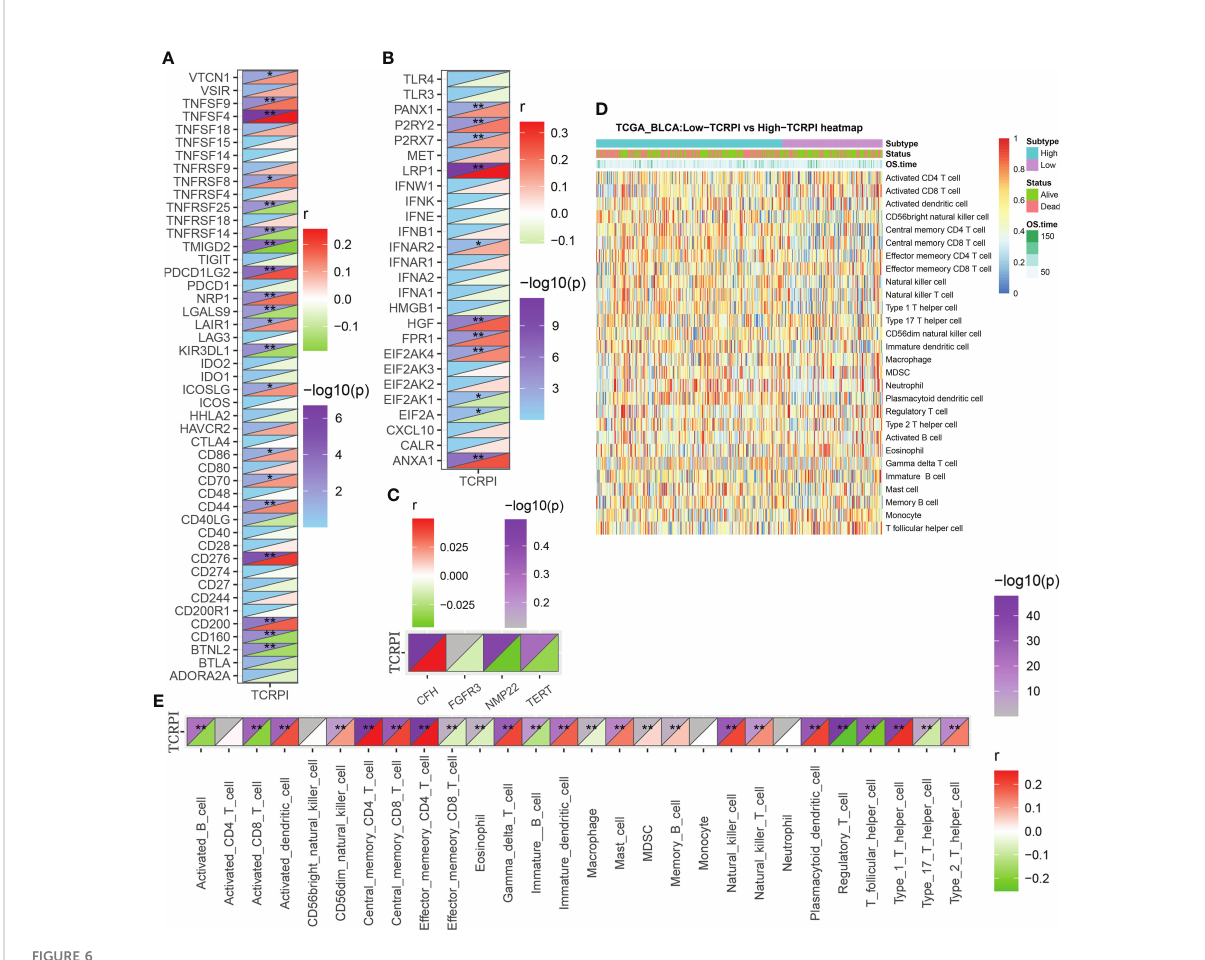
FIGURE 6 Immune landscape of TCRPI in BLCA. (A) Association of TCRPI with ICPs. (B) Association of TCRPI with ICD modulators. (C) Association of TCRPI with four bladder cancer biomarkers. (D) A heatmap showed the immune in fi ltration levels of the 28 immune cell types de fi ned by ssGSEA. (E) Association of TCRPI with 28 immune cell types de fi ned by ssGSEA. NS, no signi fi cance, *P <0.05, **P